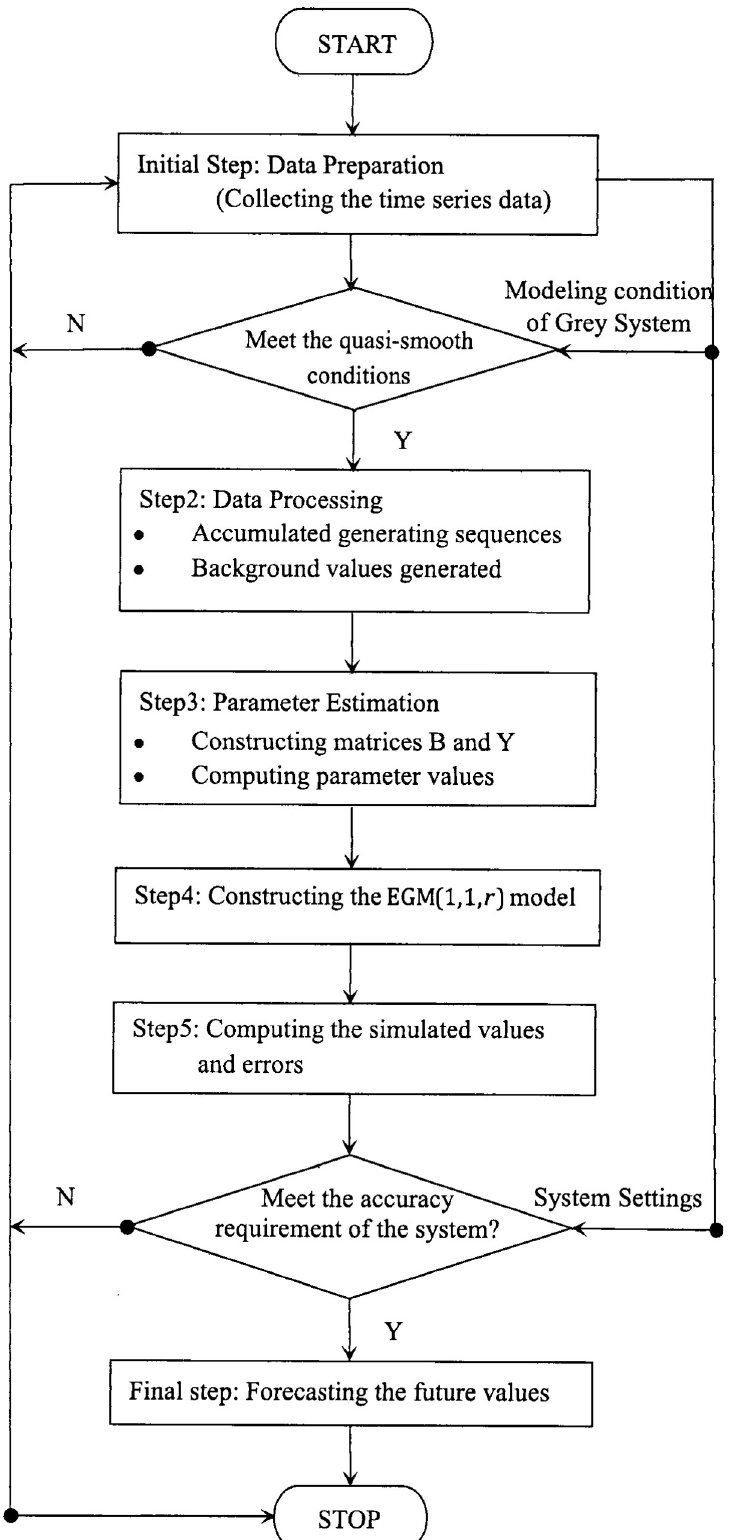
Fig 1. The flowchart of the EGM(1,1, r)